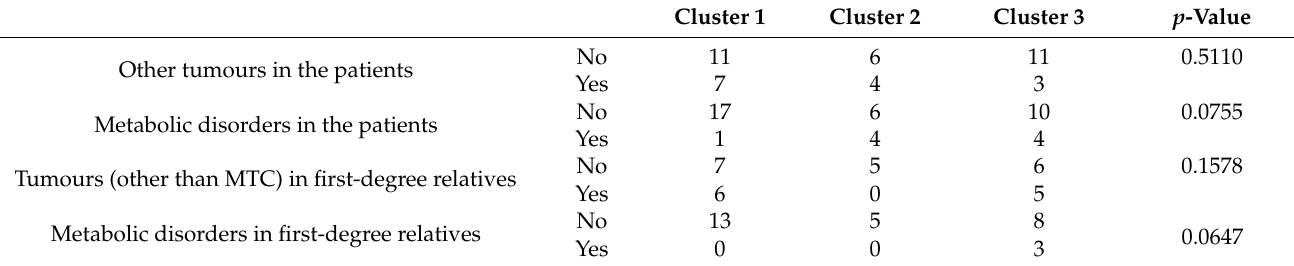
Table 4. Other disorders in the patients of the 3 clusters and their first-degree relatives, with no correction for multi- ple